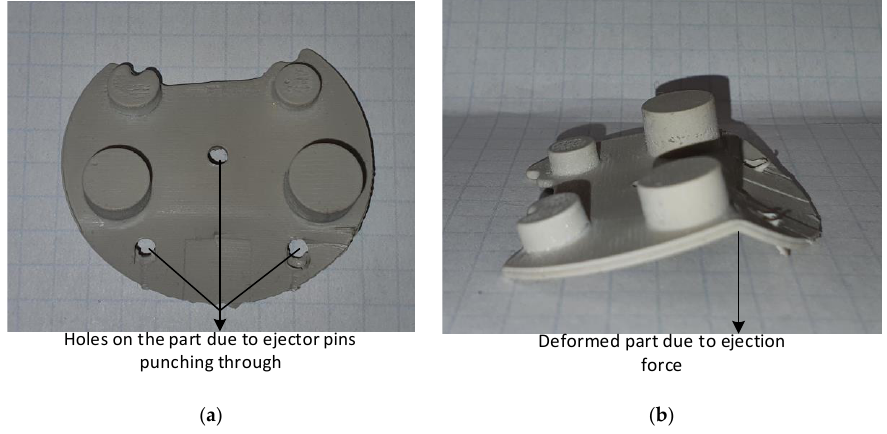
Figure 24. ( a ) Part showing holes punched by ejector pins as the parts were not completely solidified; ( b ) Deformed part during ejection stage as the part was not completely solidified.